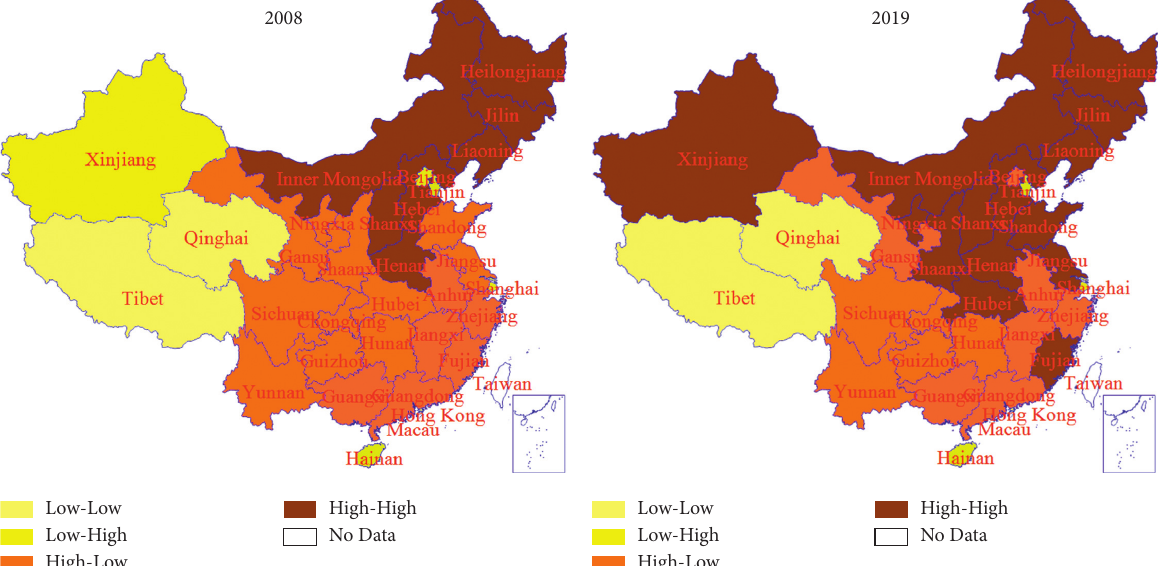
Figure 6: Regional agglomeration map of energy consumption in China in 2008 and